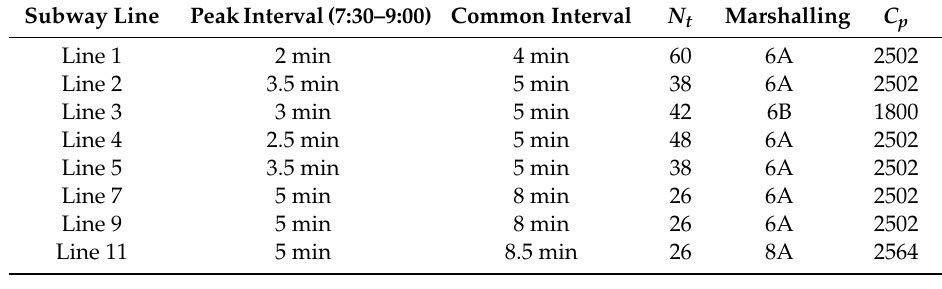
Table 3. Operation parameters of the Shenzhen subway system.